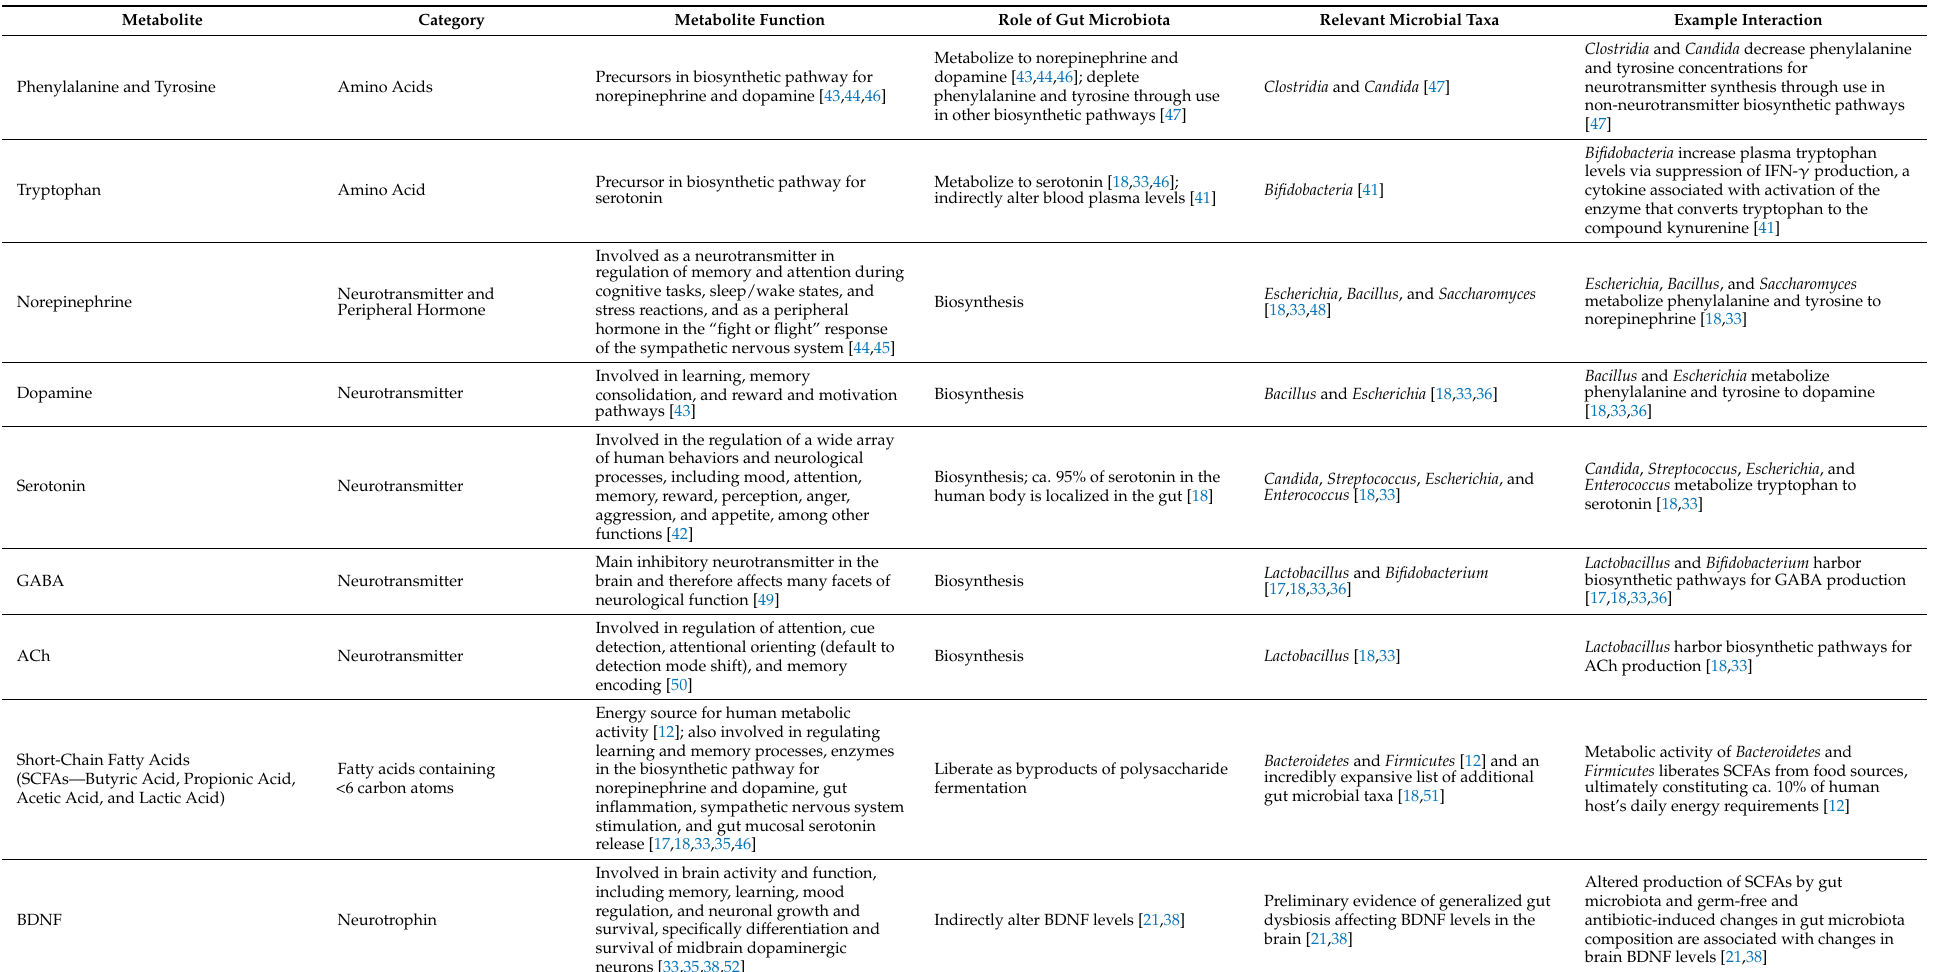
Table 1. Microbial metabolites relevant to the gut microbiota–gut–brain axis, the function of these metabolites within the human host, and the role of the gut microbiota in the production and availability of these